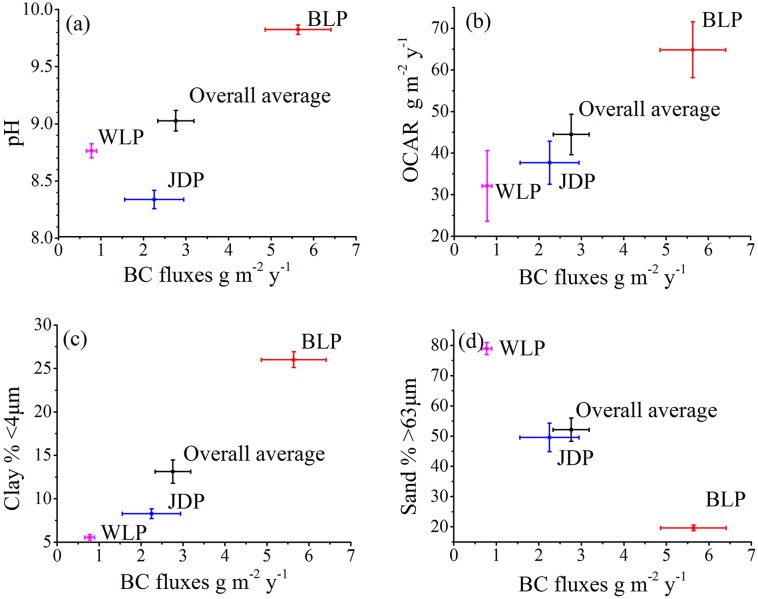
Effect of environmental parameters on BC fluxes in the three profiles of the Songnen Plain (values are expressed as means and standard errors, n≥12).(a) pH, (b) organic carbon accumulation rates, (c) clay percentage, and (d) sand percentage.